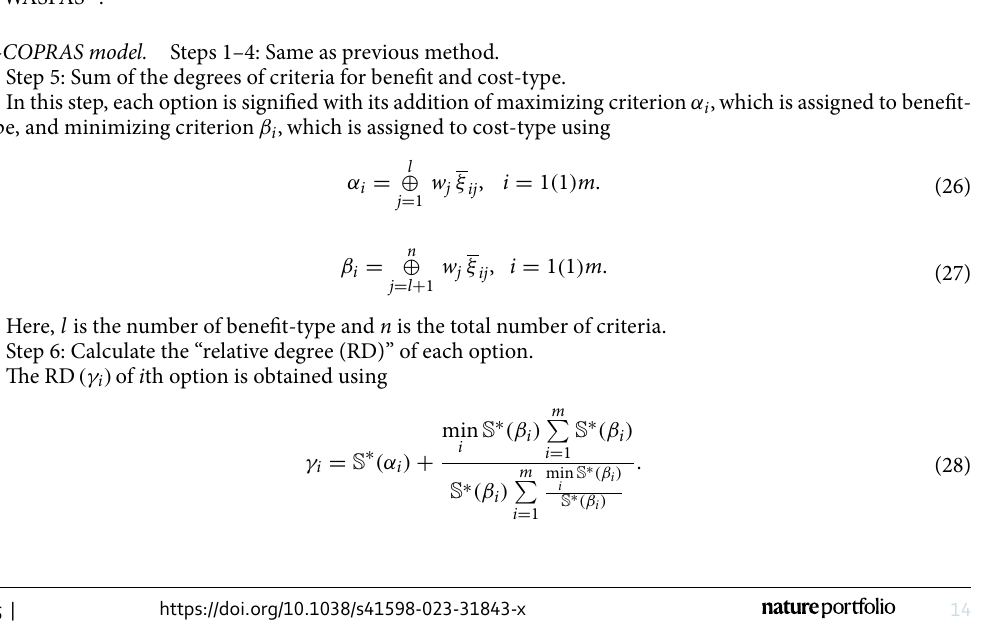
From Table 12 and Eq. (22), the score degrees S ∗ Eq. (23)-Eq. (24), the OPR ( M i ) and UD ( Q i ) of each SIBO is calculated and specified in Table 13. Then, from Eq. (25), the prioritization of the SIBOs is determined as M 1 ≻ M 2 ≻ M 3 . Hence, the desirable alternative building is M 1 .